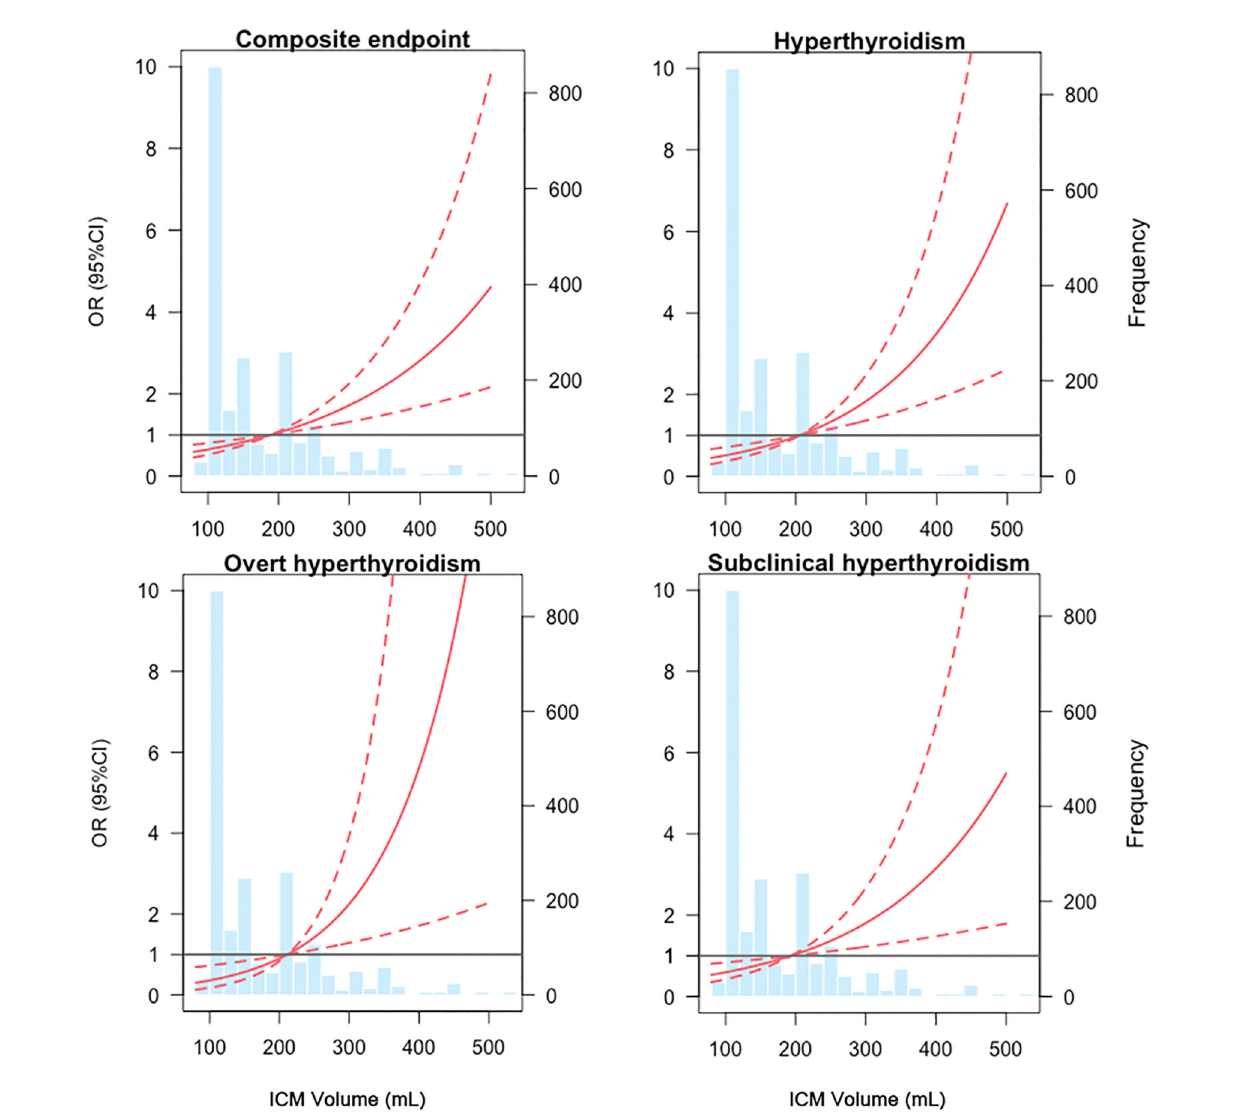
FIGURE 2 | Dose-response relationships between ICM volume and composite endpoints from restricted cubic splines model. The solid red lines are the estimate of odds ratios, with dashed red lines showing 95% con fi dence intervals derived from restricted cubic spline regressions. Reference lines for no association are indicated by the grey bold lines at an odds ratio of 1.0. Vertical blue bars represent the frequency of ICM volume in a histogram. ICM, iodinated contrast media, OR, odds ratio, CI, con fi dence